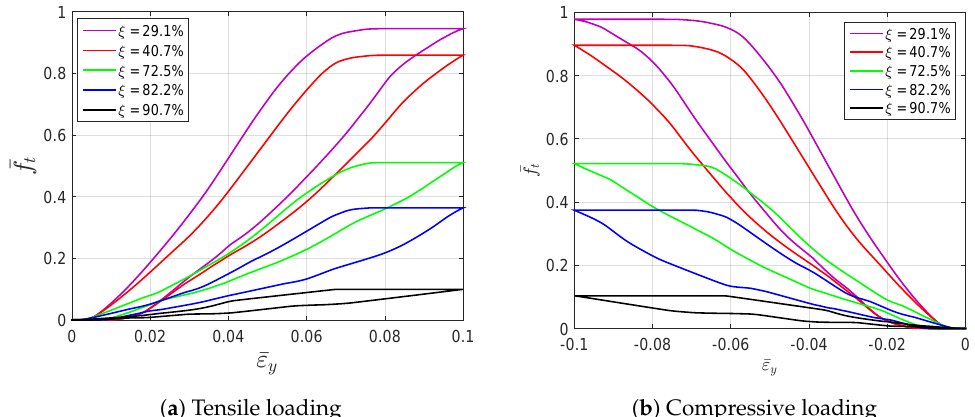
Figure 8. The evolution of the martensitic volume fraction versus the averaged strain curves simulated by RVEs with different void volume fractions.